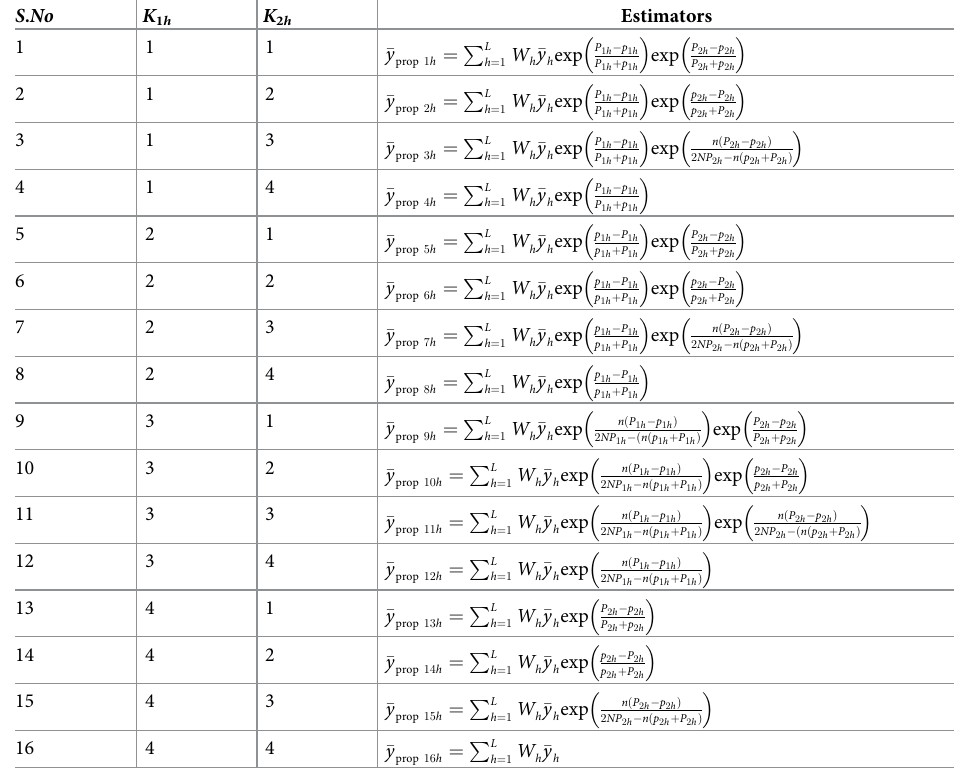
Substituting different values of K (i = 1,2,3,4) in (54), we can generate many more different ih types of estimators from our general proposed class of estimators, given in Table 4. Table 4. Some members of the proposed class of family of estimators � y prop h